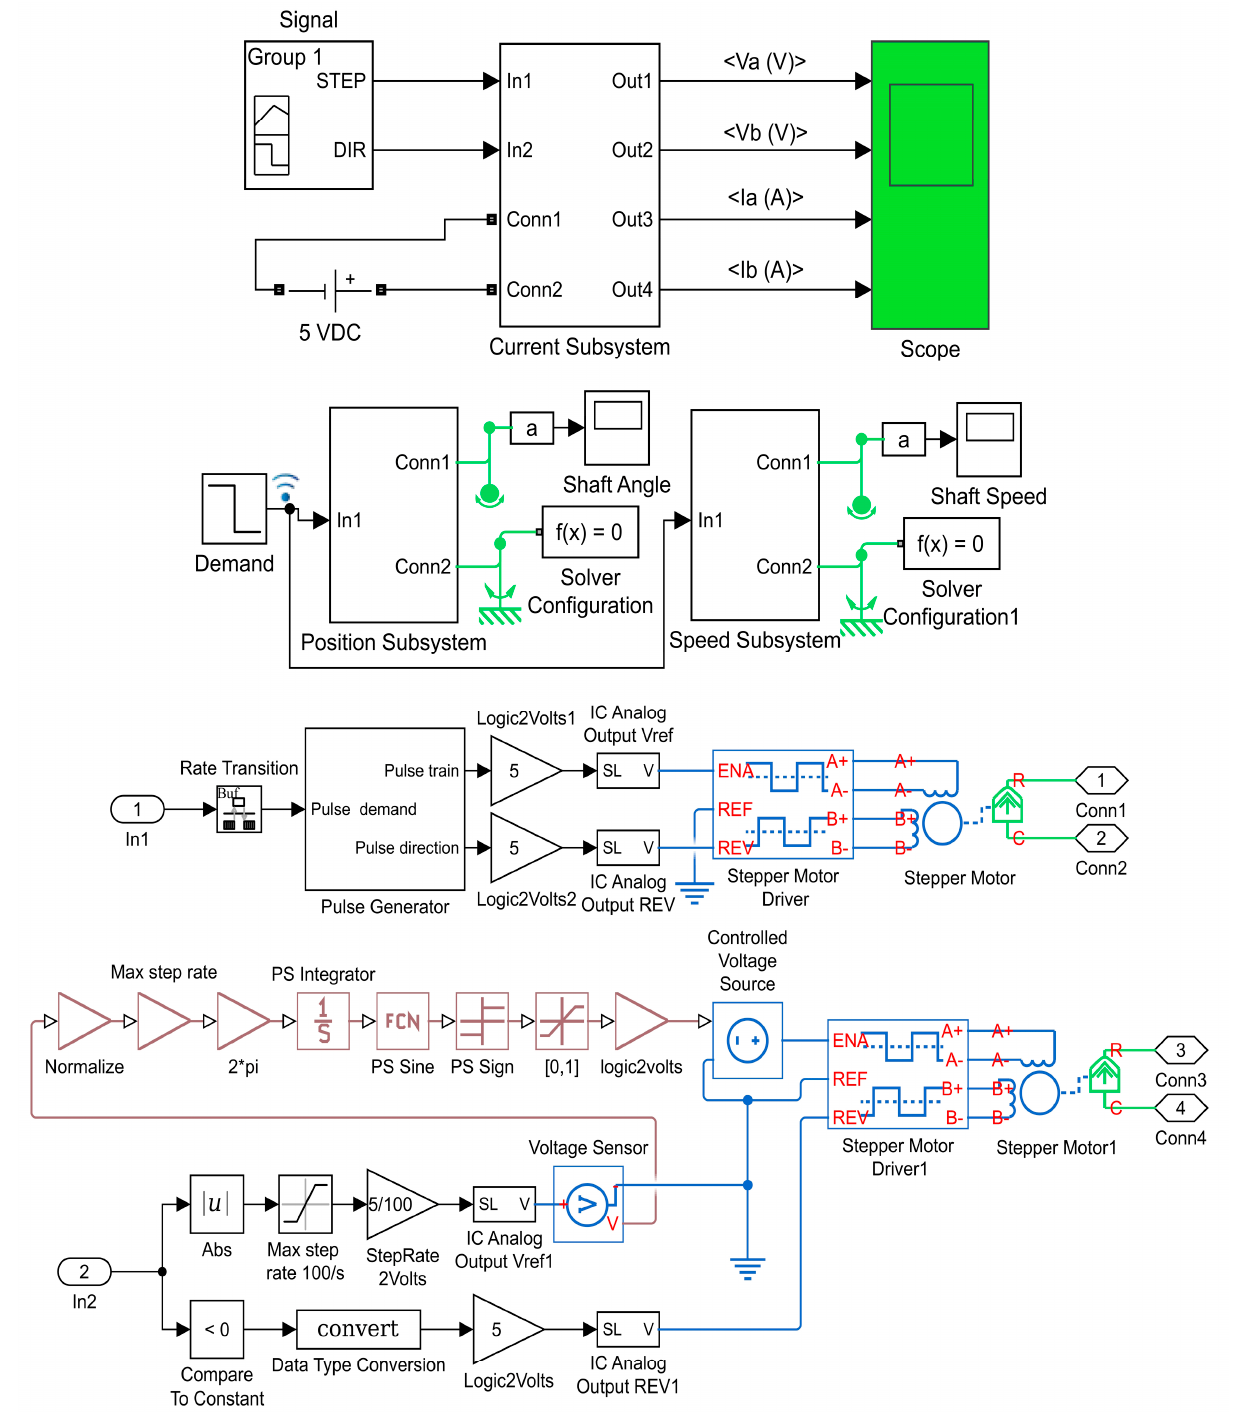
Figure 8. The modeling of the control system. Figure 8. The modelling of the control